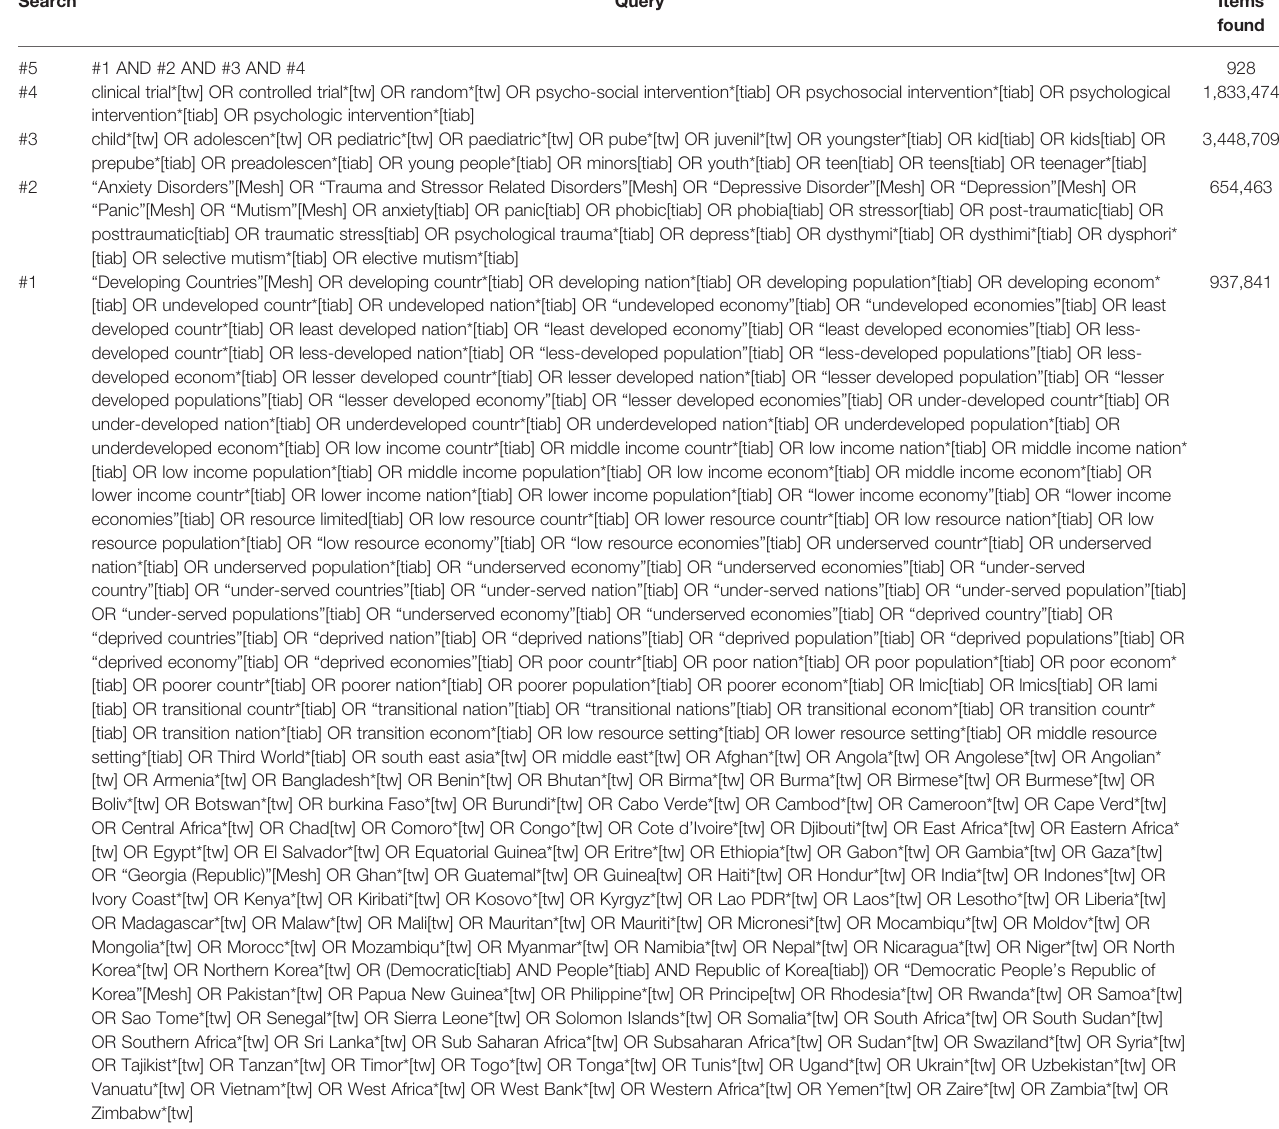
TABLE 2 | Search string PubMed session results (14 Dec 2018). Search Query Items